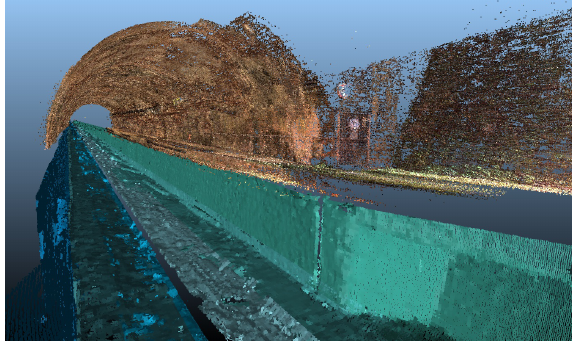
Figure 10. Rough model obtained from dynamic acquisitions and an approximated trajectory of the